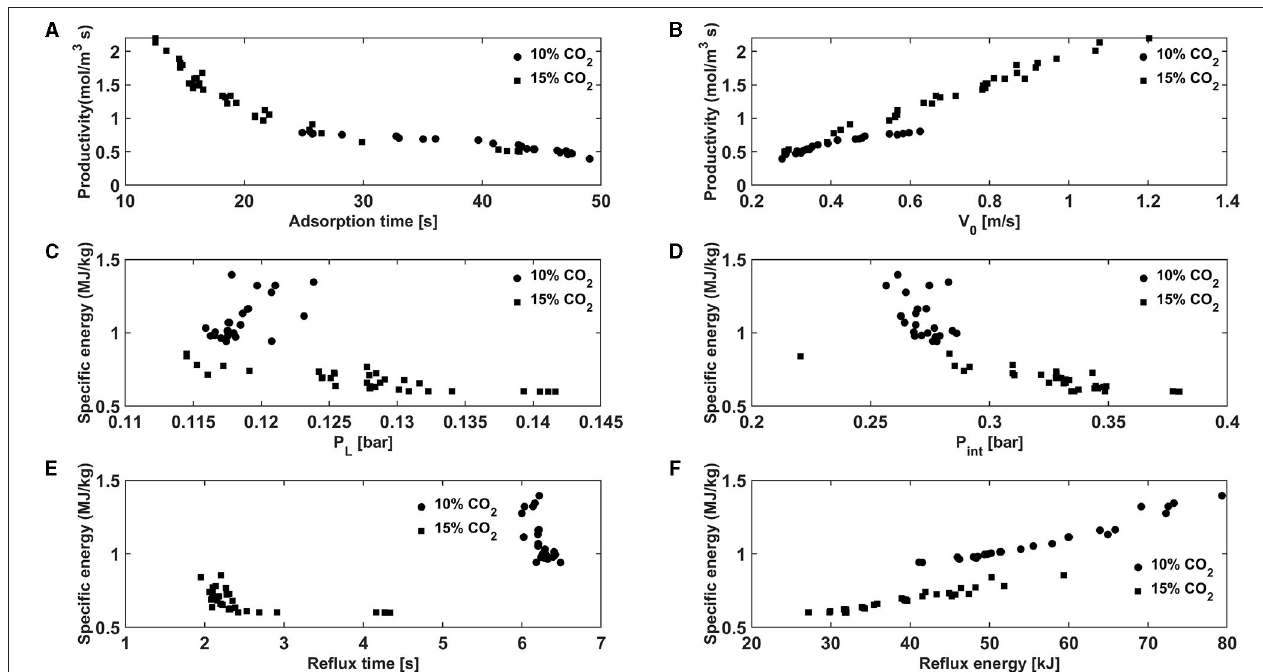
FIGURE 9 | Productivity vs. (A) adsorption time and (B) interstitial feed velocity and specific energy vs. (C) counter-current evacuation pressure, (D) co-current evacuation pressure, (E) reflux step duration and (F) reflux step energy